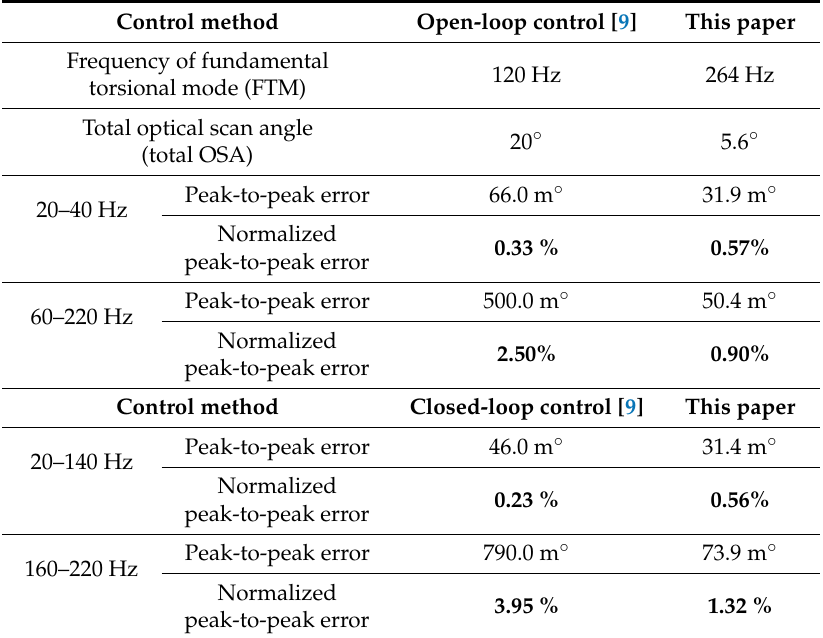
Table 2. Performance comparison between open-loop control and the proposed